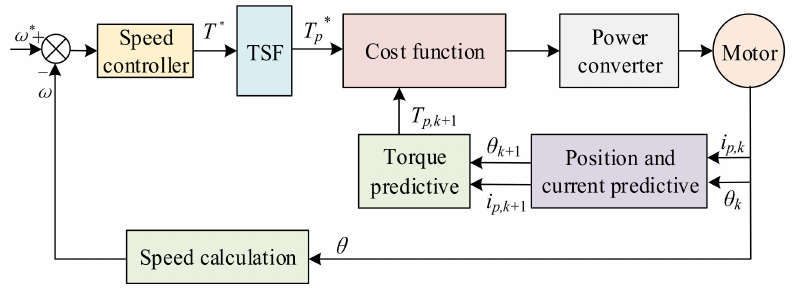
Figure 4. The control block of the MPTC